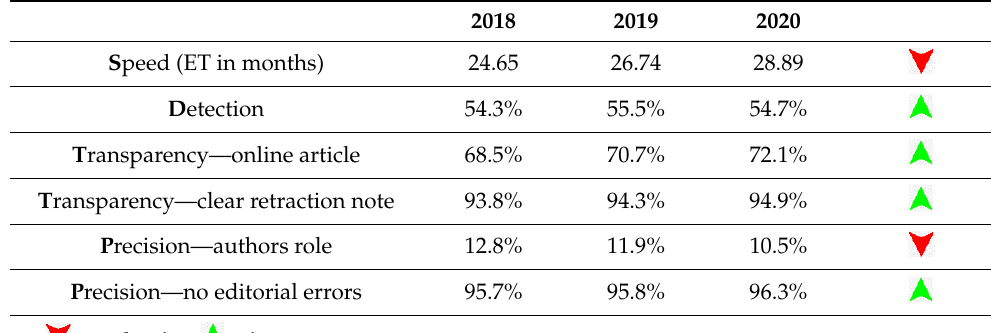
Table 11. Changes of main components of SDTP score for 2018–2020.